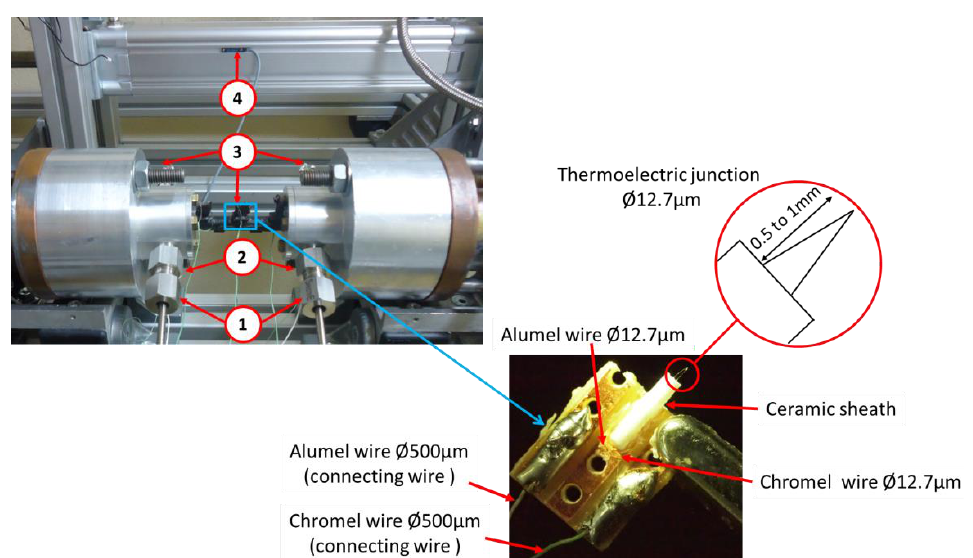
Figure 4. Positions of the different sensors 1: hot-wire sensors, 2: pressure sensors, 3: microther- mocouples, 4: magnetic proximity sensor. couples, 4: magnetic proximity